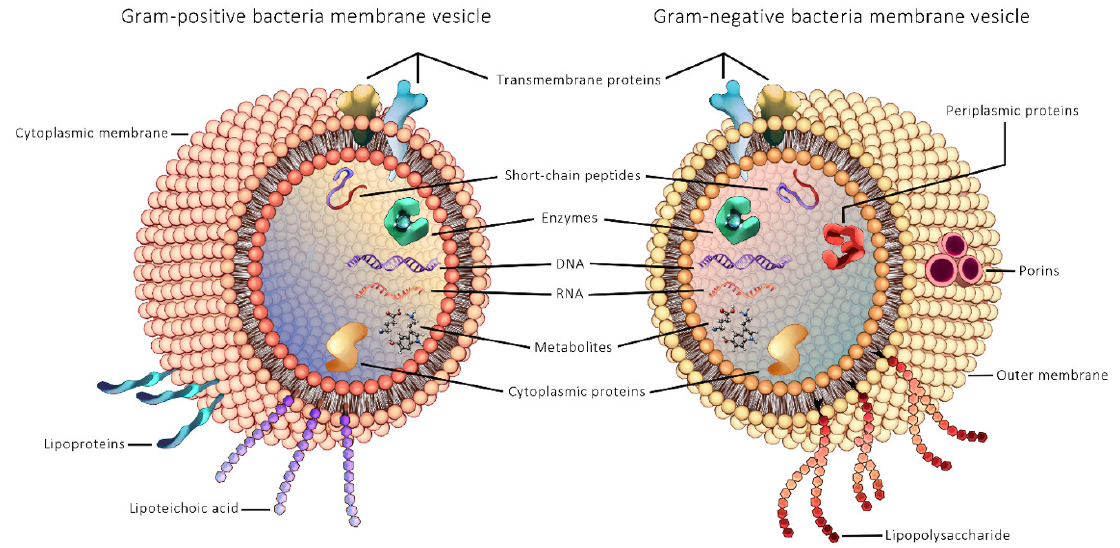
Figure 2. General structure of Gram-positive and Gram-negative bacterial extracellular vesicles.